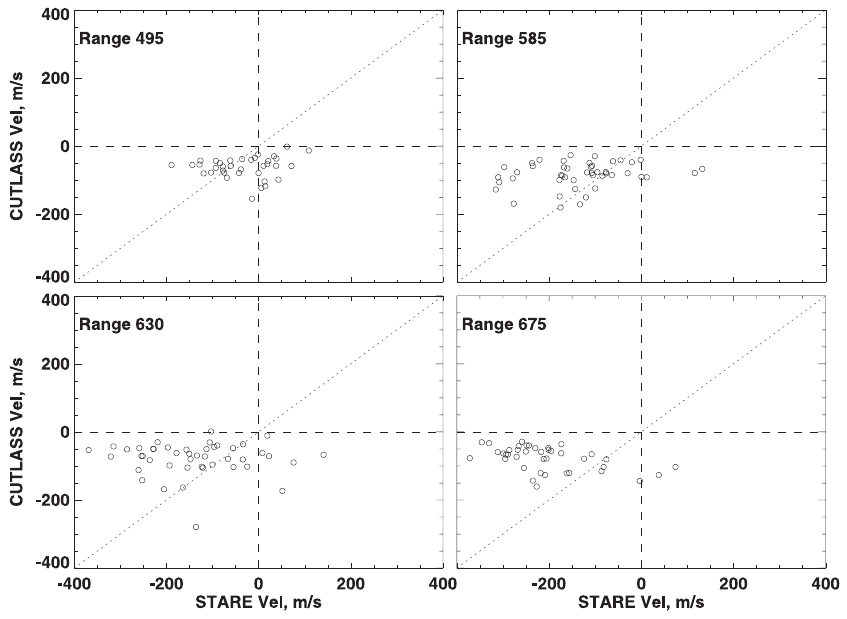
Fig. 12. Scatter plot of Hankasalmi CUTLASS velocity versus Finland ve- locity at several slant ranges for the period of 14:00–18:00UT when both CUTLASS and STARE radars observed echoes from the